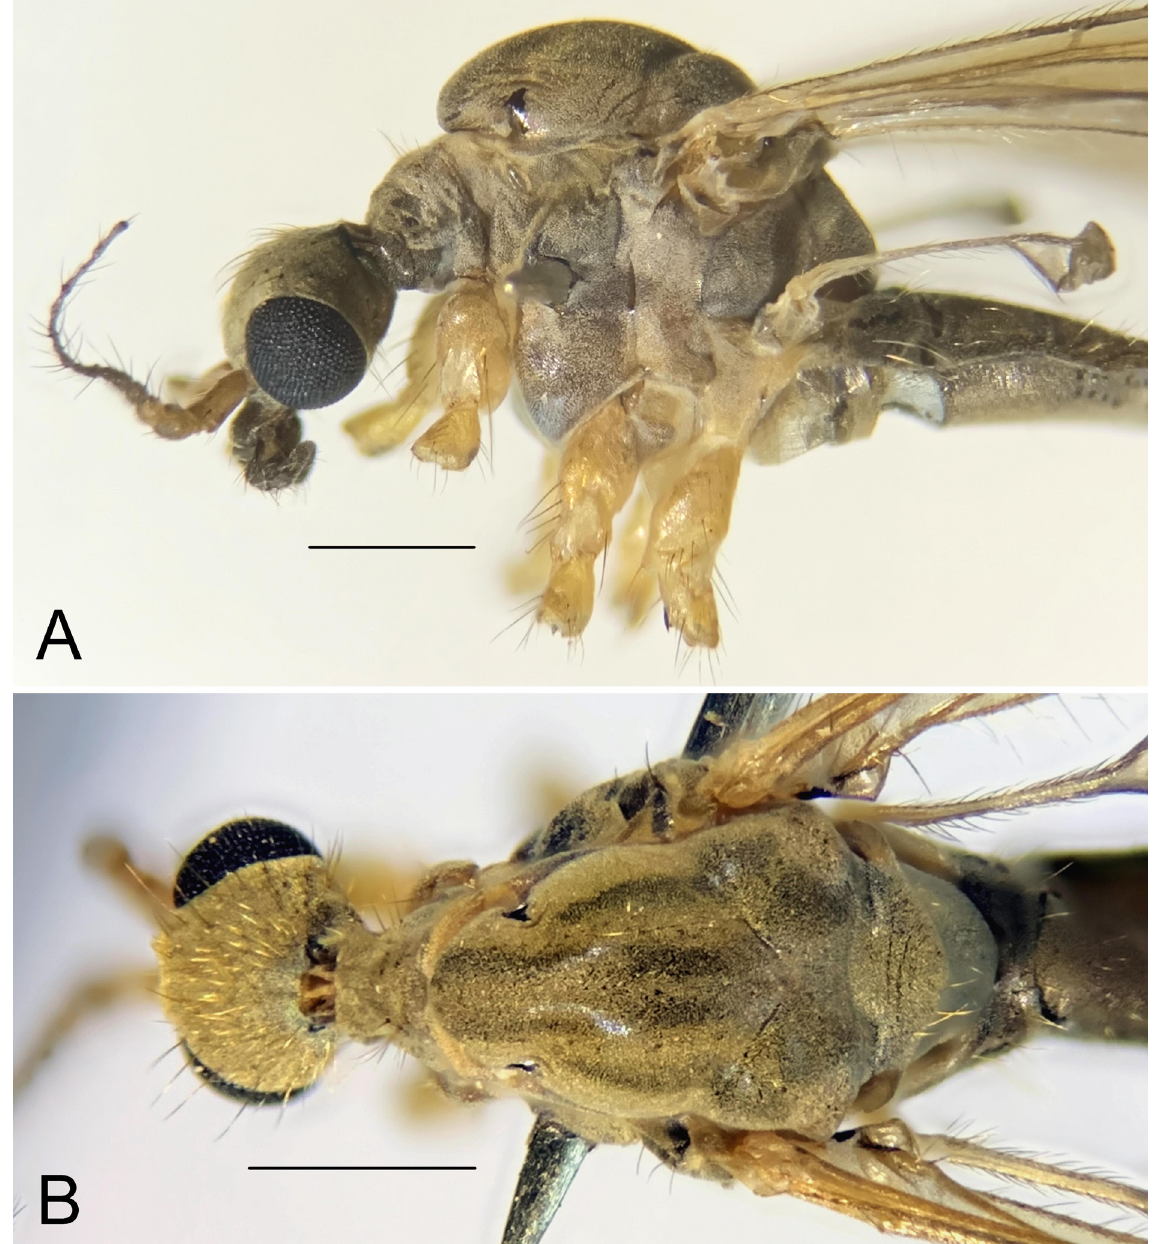
Fig. 2. Dicranophragma (B.) relictum Mederos sp. nov., holotype, ♂ (MZB 2019-0985, MNCB). Head and thorax. A . Lateral view. B . Dorsal view. Scale bars = 0.5